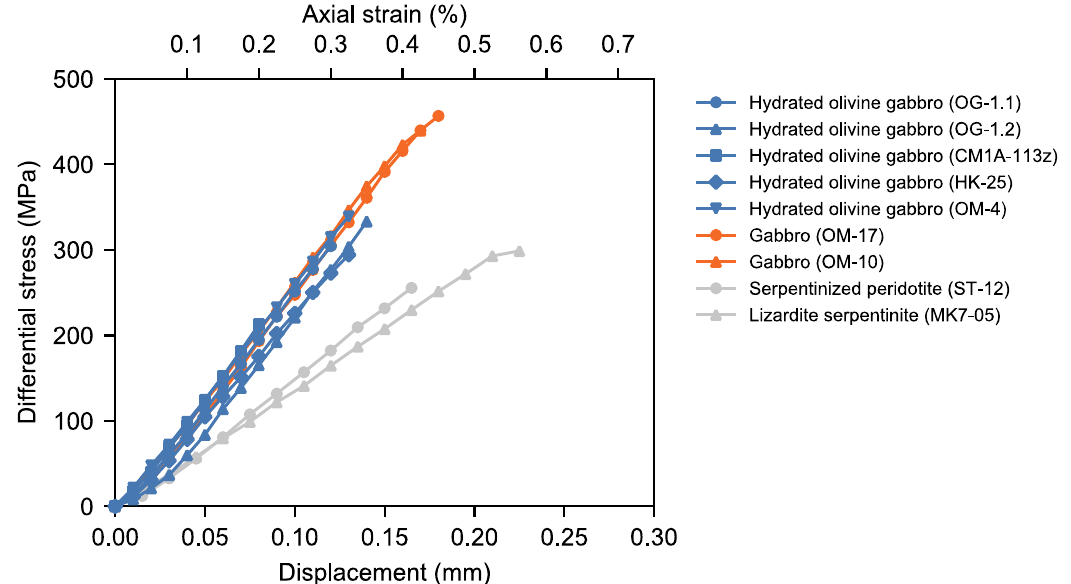
Figure 3. Mechanical data for each triaxial deformation experiment. Differential stress is plotted as a function of axial displacement. Axial strain, as inferred from displacement, is also shown on the upper axis.